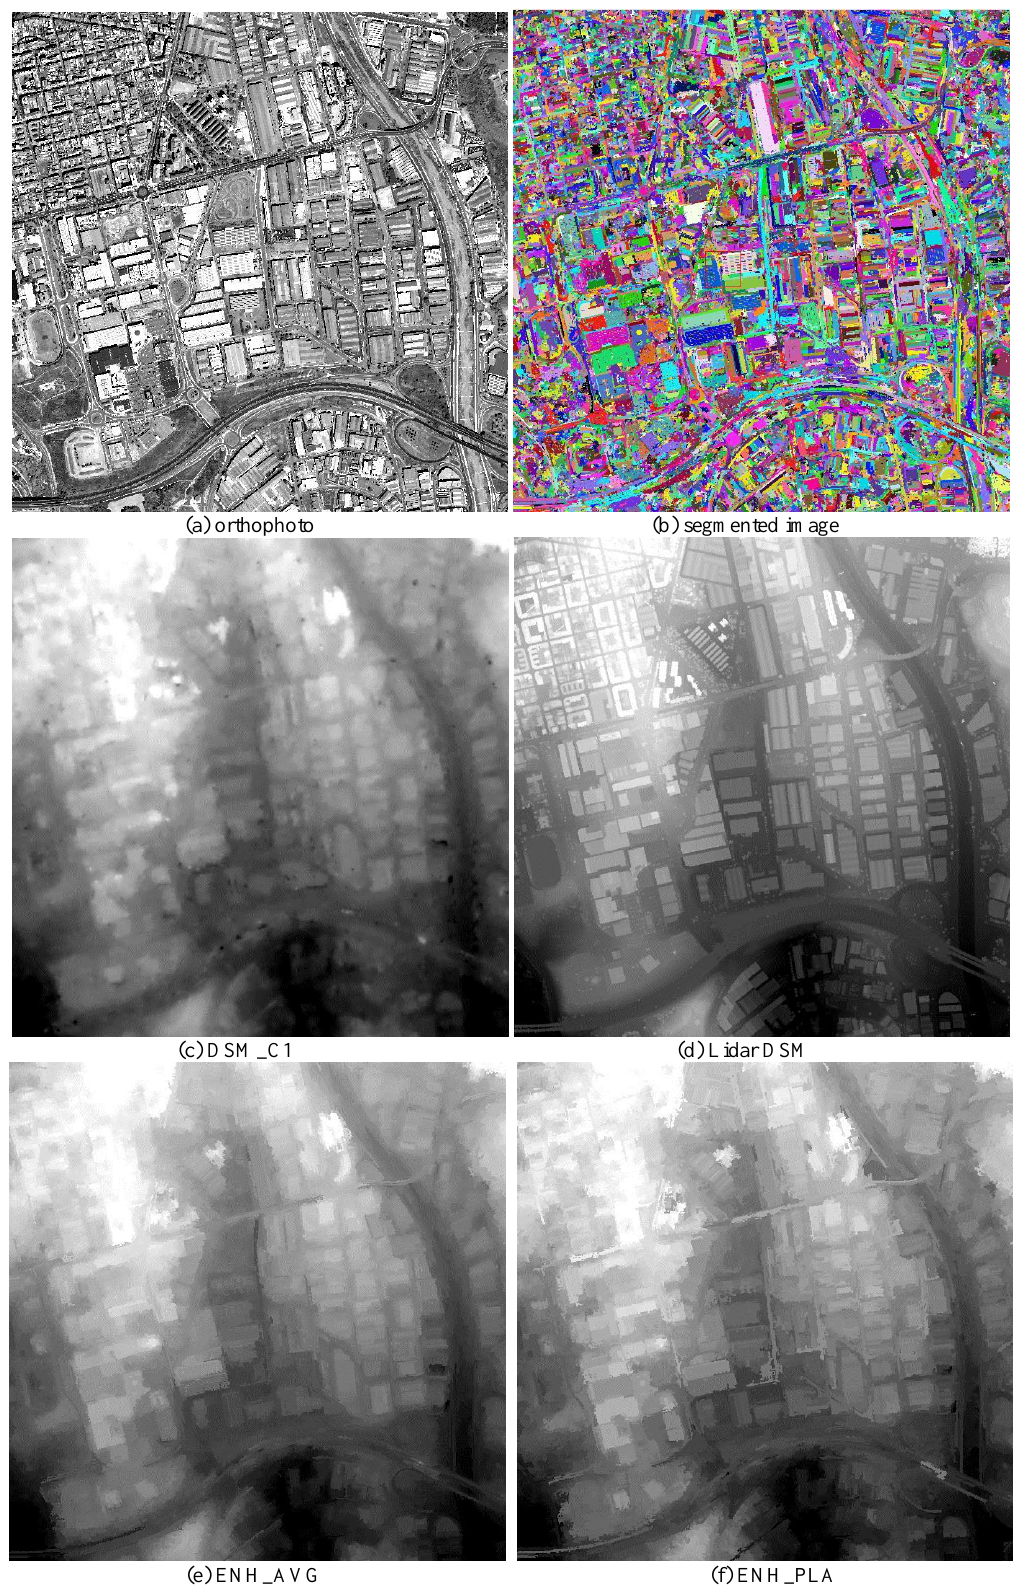
Figure 4. Segmentation results (left) on a WV1 orthoscene (left), using alfa = omega = 50 over a